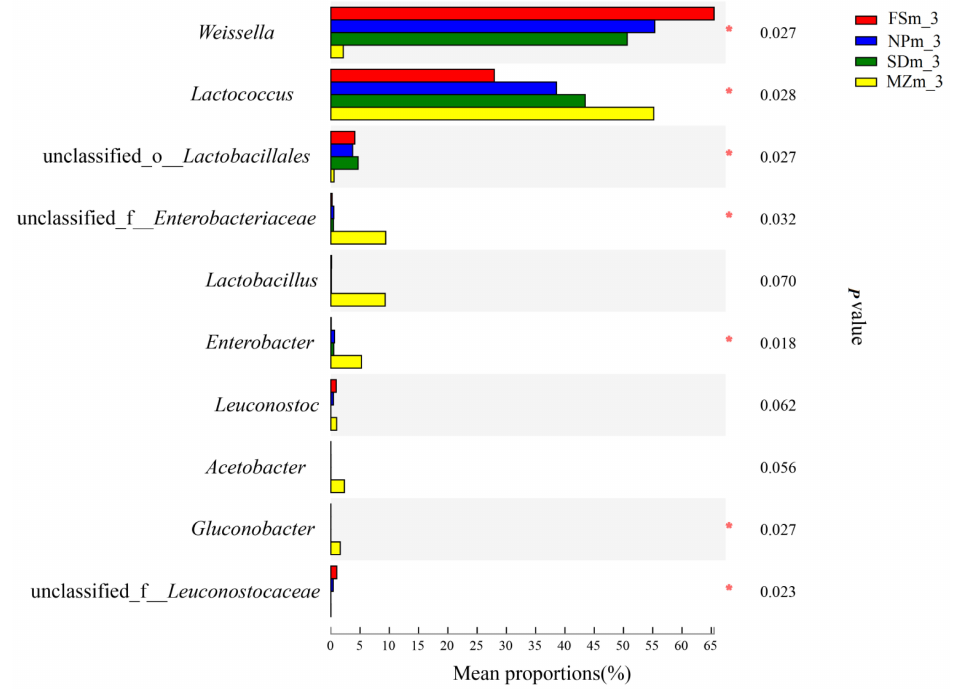
Figure 5. One-way analysis of variance bar plots of the genus level (10 most abundant genera) among different forage sorghum silage groups. *, 0.01 < p < 0.05. FSm, forage sorghum microbiota; NPm,